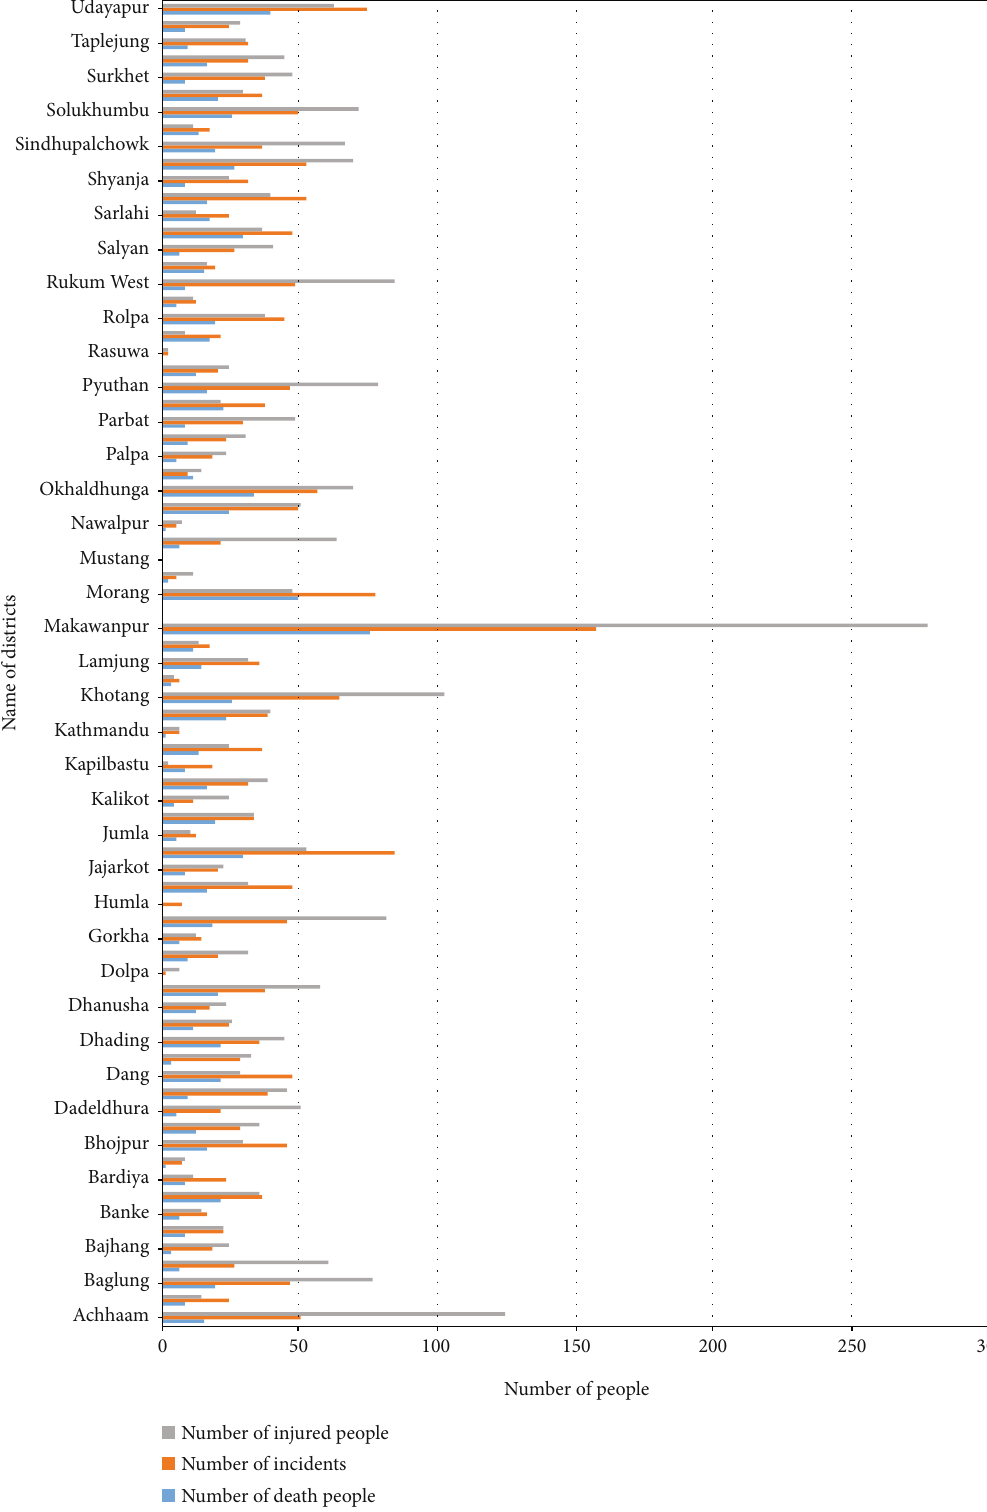
Figure 4: The bar diagram of the distribution of the lightning phenomena and severe thunderstorms over the seventy-seven districts of Nepal during the period of January 2011 to December